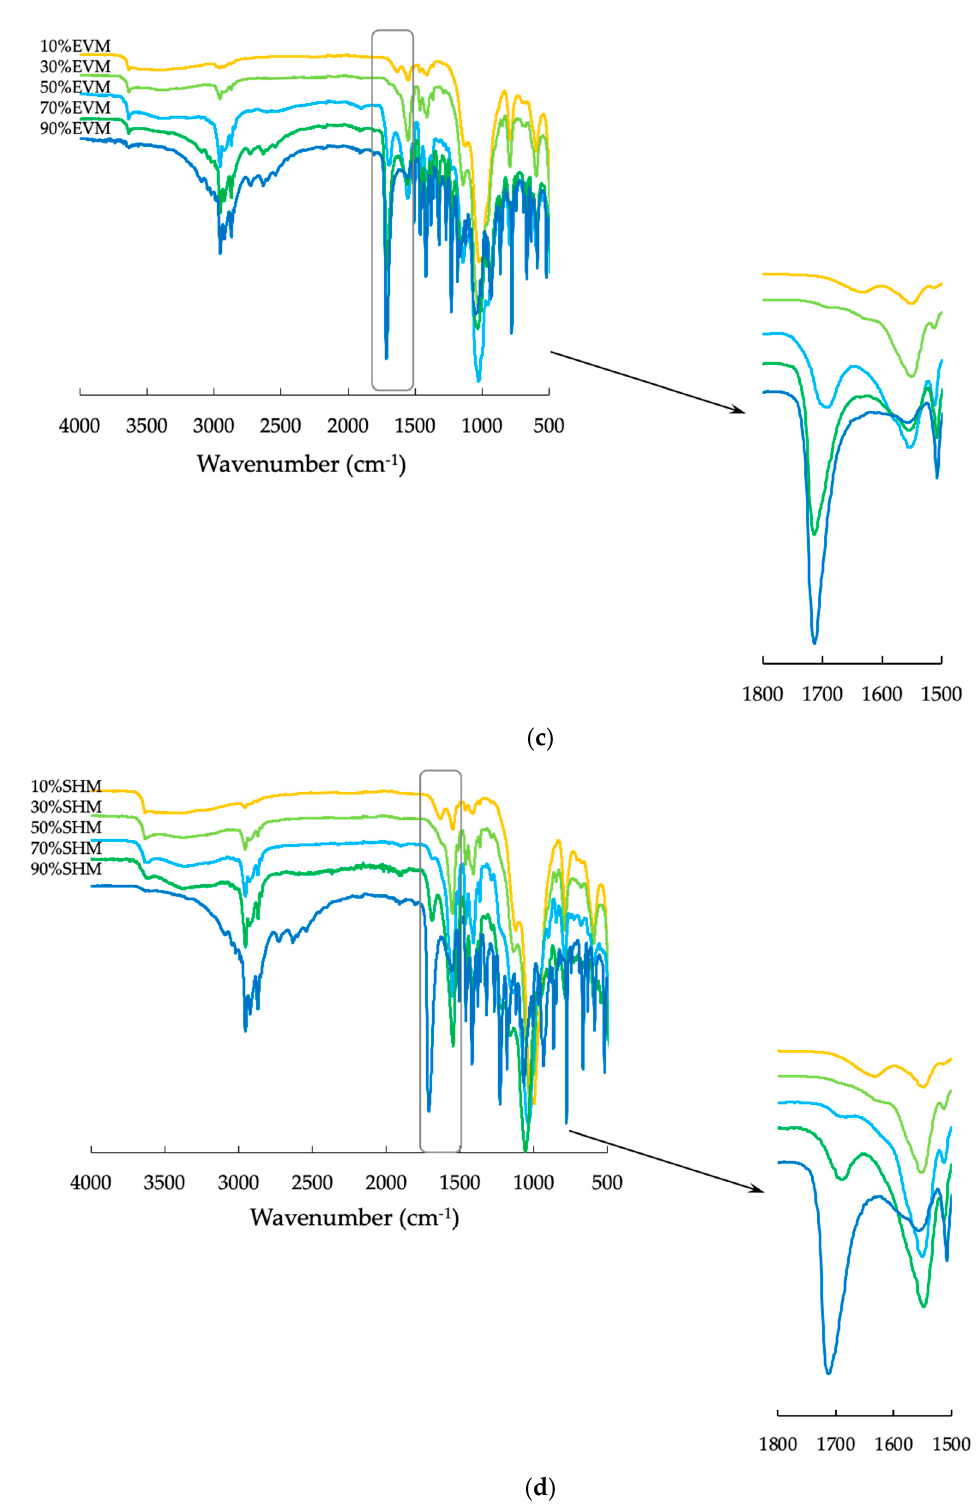
Figure 6. FTIR spectra of various samples. ( a ) PS300, and IBU crystals; ( b ) PMs; ( c ) EVMs; ( d ) SHMs.